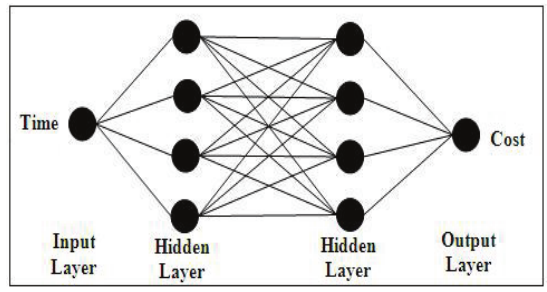
Fig. 3. Neural network architecture used for nonlinear TCT